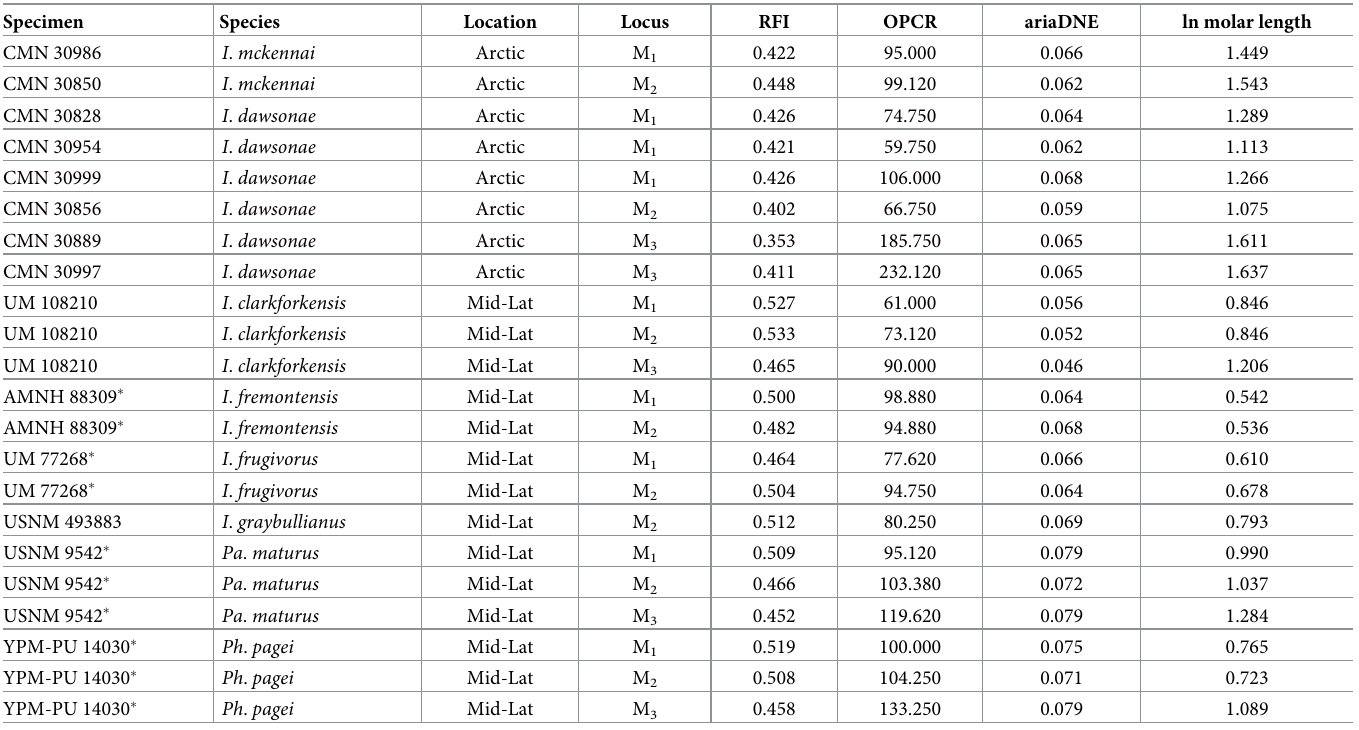
Table 3. Dental topography metrics for paromomyid lower molars.